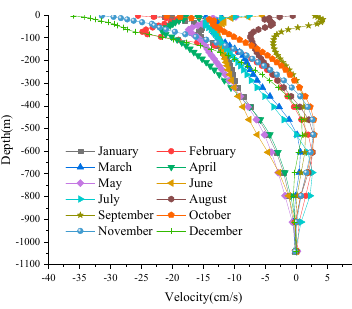
Figure 2. Typical current velocity map from January to December in the South China Sea.